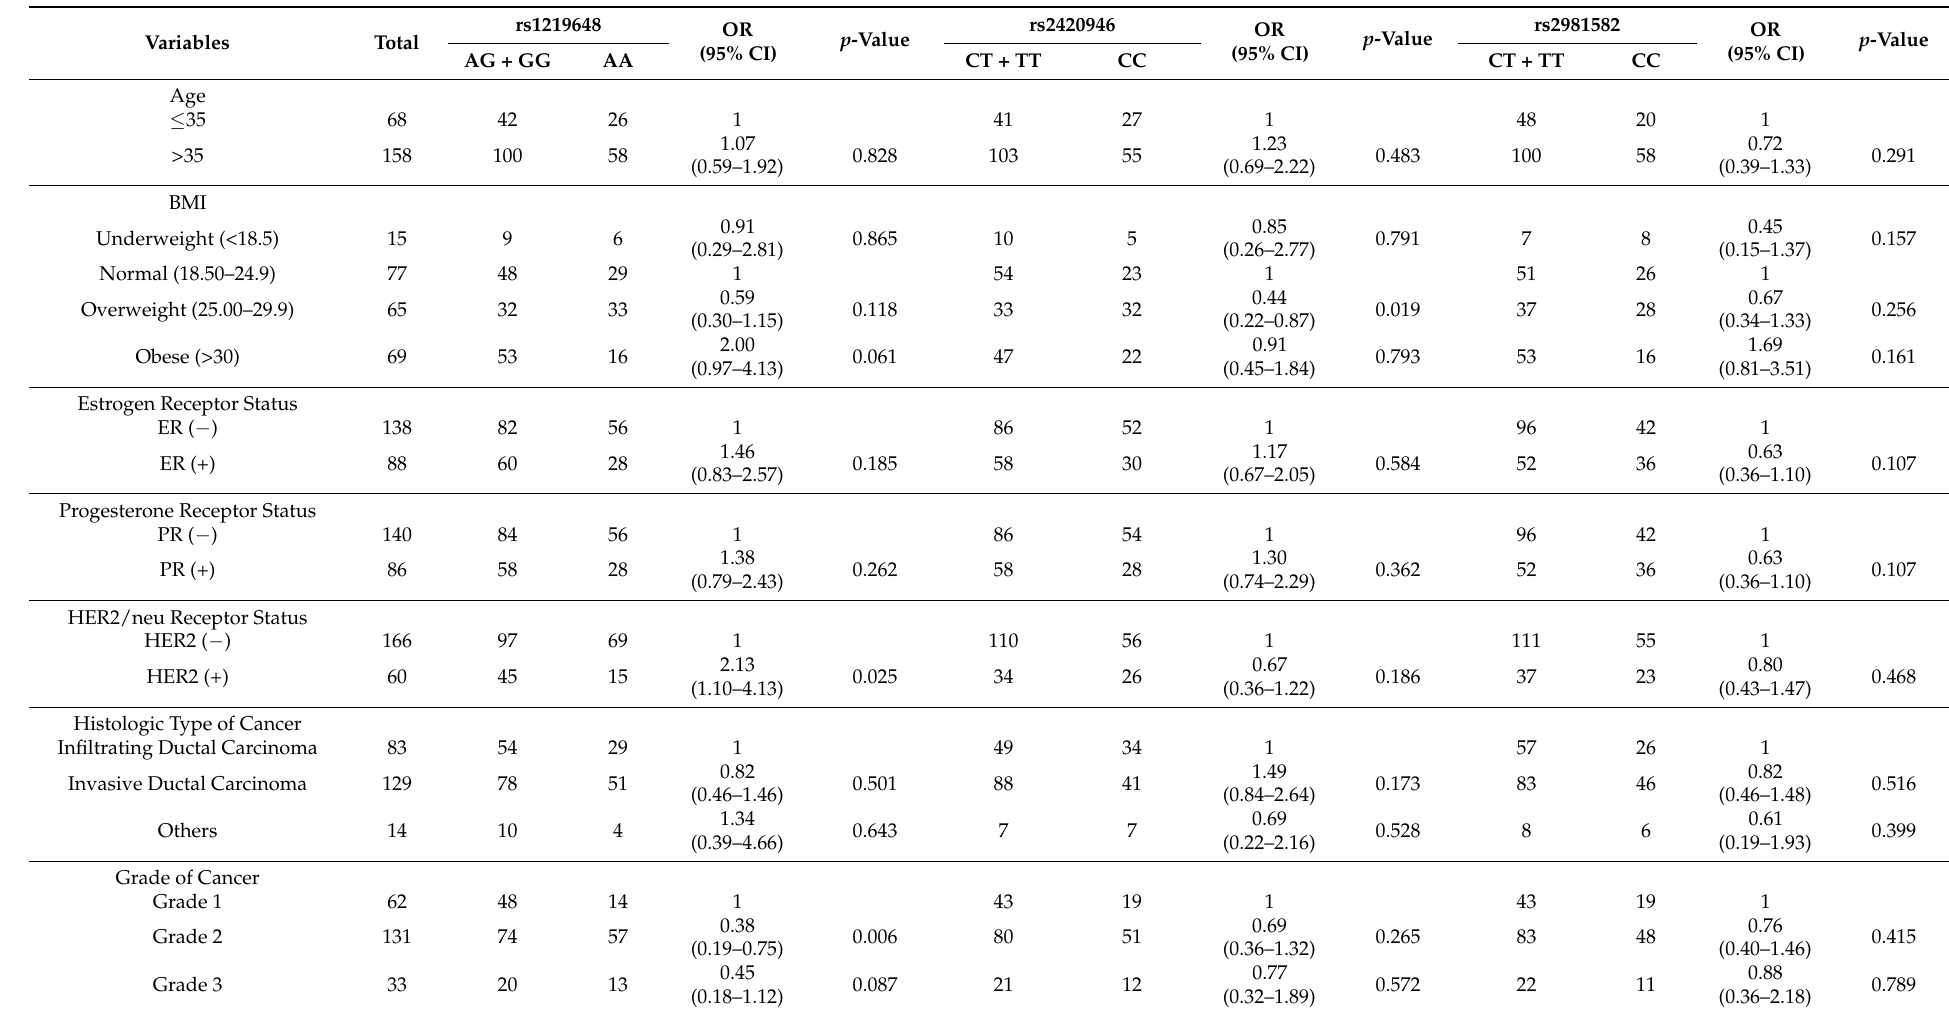
Table 4. Associations of FGFR2 rs1219648, rs2420946, and rs2981582 polymorphisms with clinicopathological